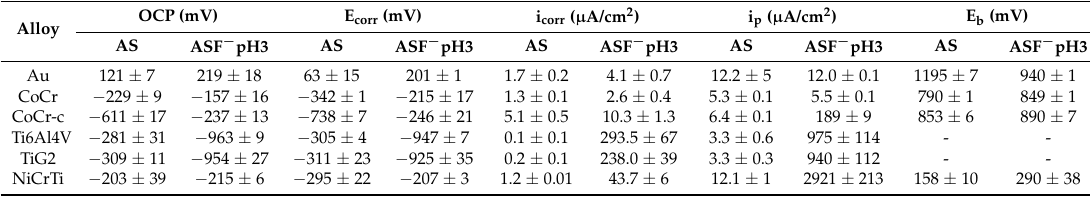
Legend: Au: gold-palladium alloy; CoCr: cobalt-chromium alloy; CoCr-c: cobalt-chromium cast alloy; NiCrTi: nickel-chromium-titanium alloy; Ti64: Titanium-6Aluminium-4Vanadium Titanium alloy); TiG2: Titanium grade 2; rep: repetition of the